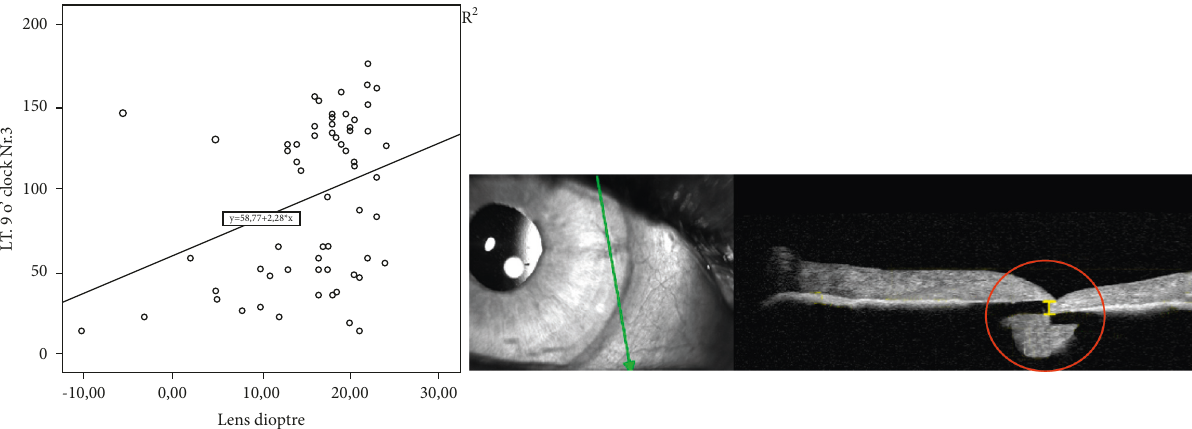
Figure 5: Relationship between the IOL diopter and width offset of the IOL haptic shown with Pearson’s correlation and the corresponding OCT picture of the measuring point